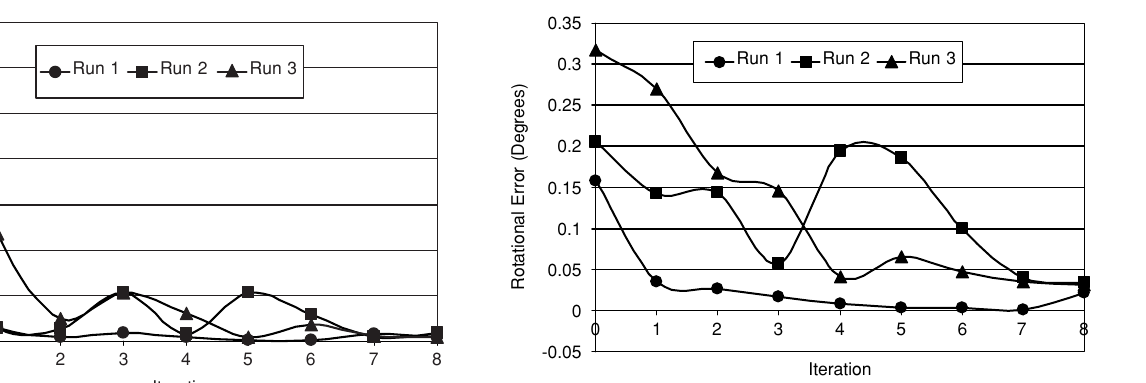
Figure 3 Translational errors versus iteration number.